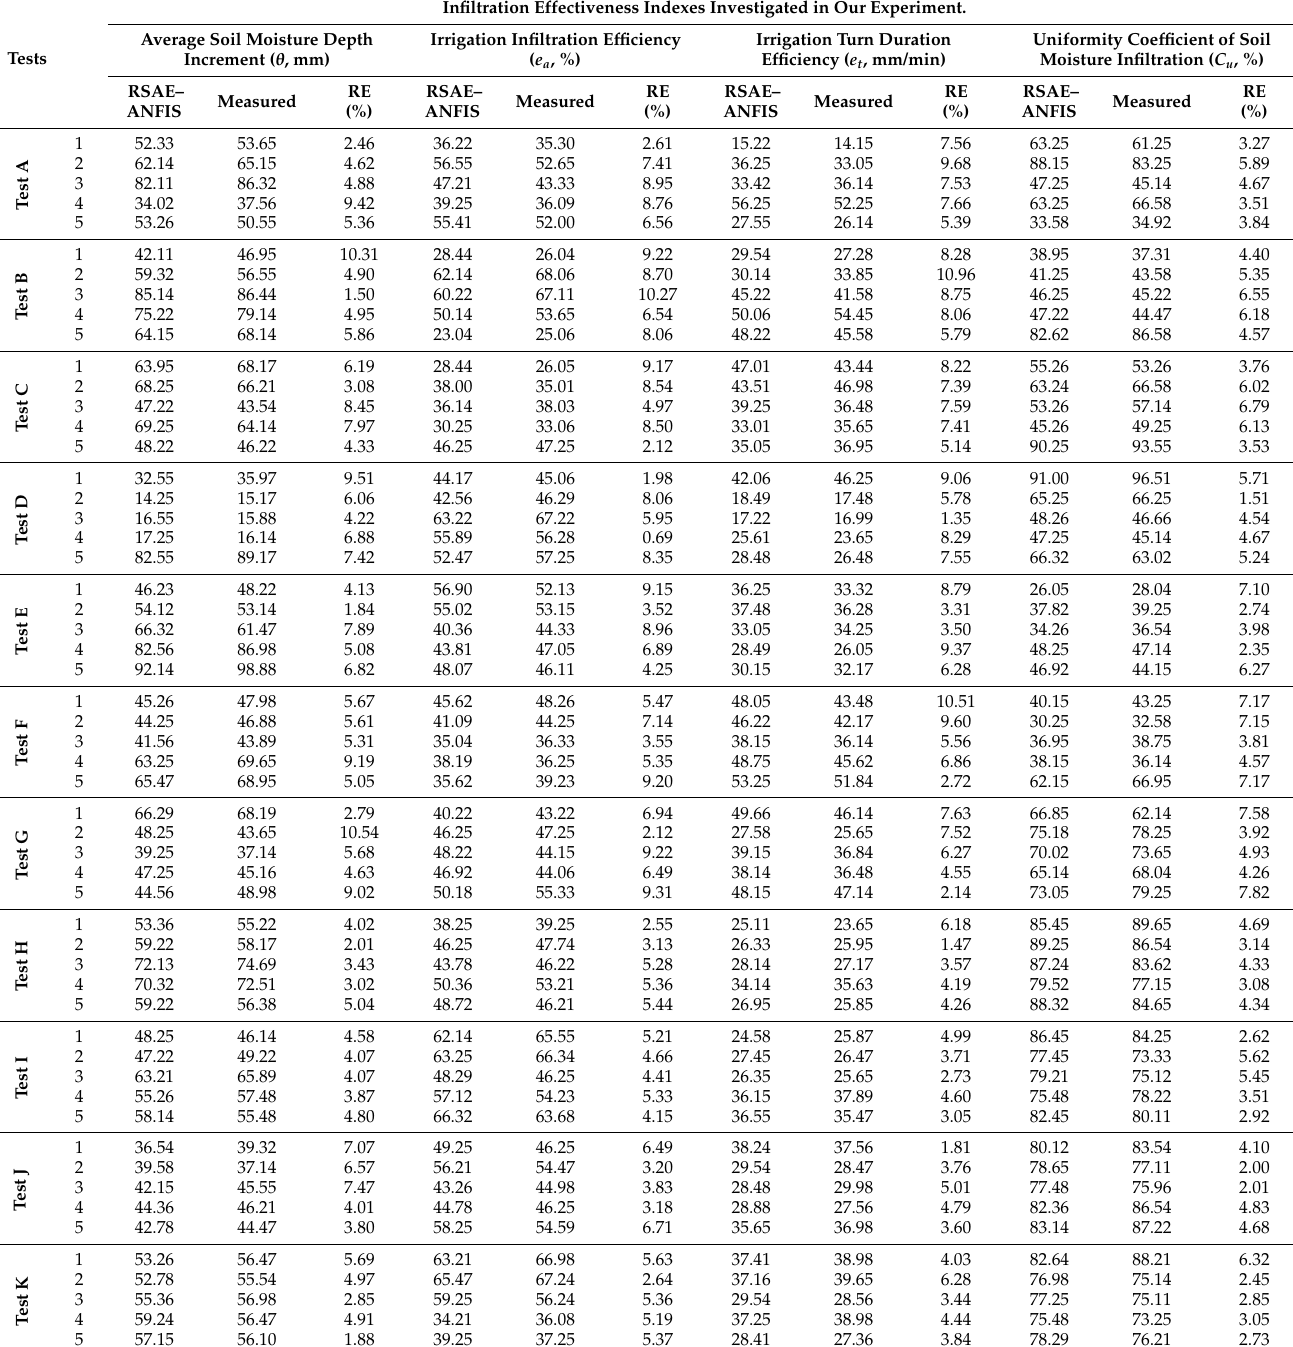
Table 4. Comparisons between the predicted and measured infiltration effectiveness indexes on different soil depth